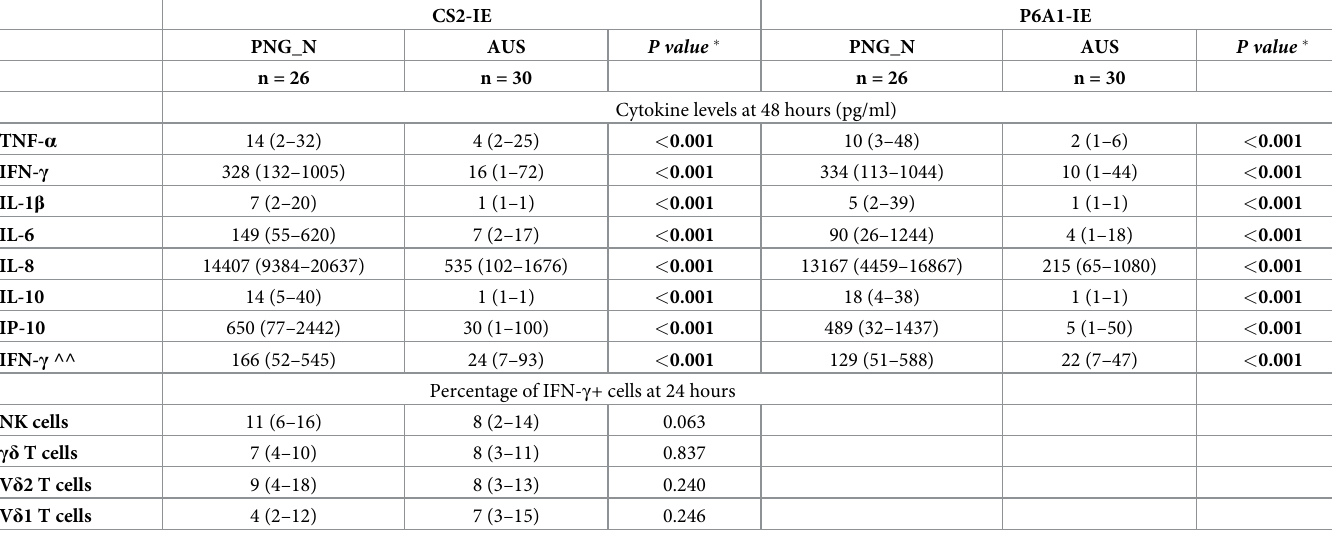
Table 3. Cytokine secretion and cellular responses to malaria-IE in PNG and Australian women.